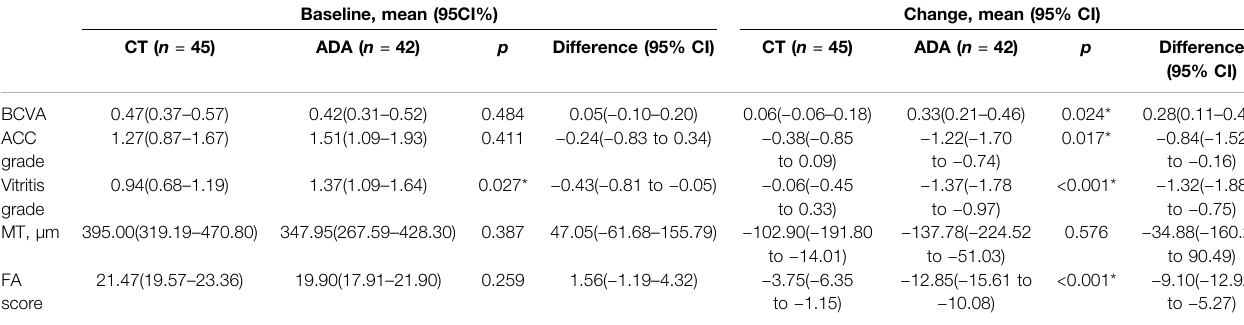
TABLE 3 | Clinical features of 87 eyes with retinal vasculitis before and change in clinical features after receiving different